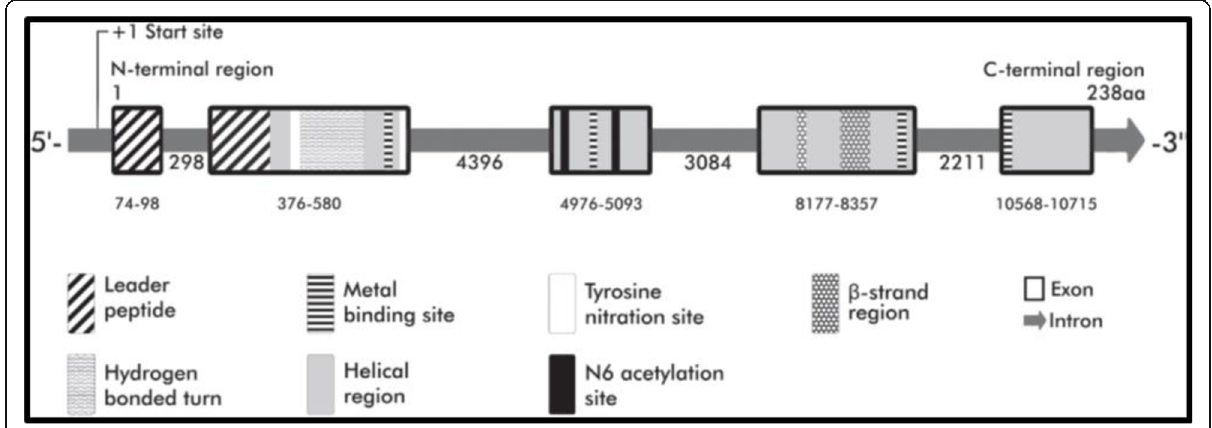
Fig. 1 Genomic organization of the human MnSOD gene